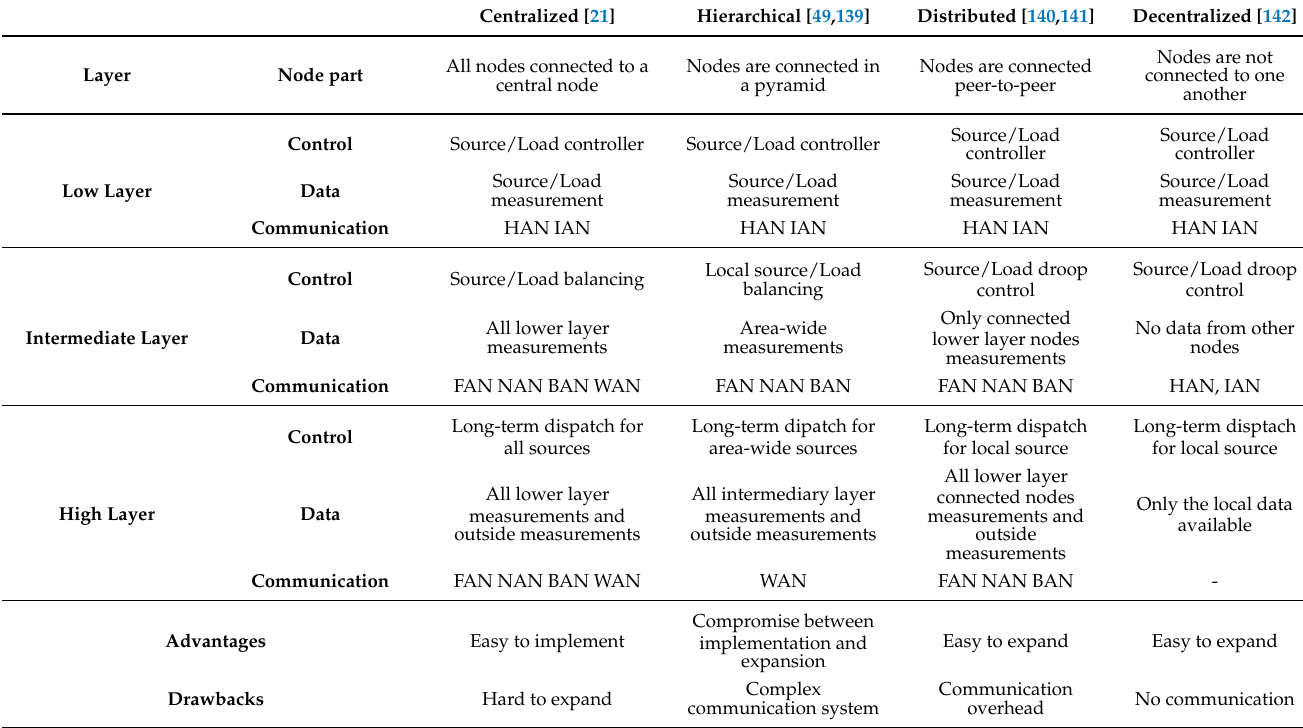
Table 4. Information component architectures and their layers, adapted from [24].